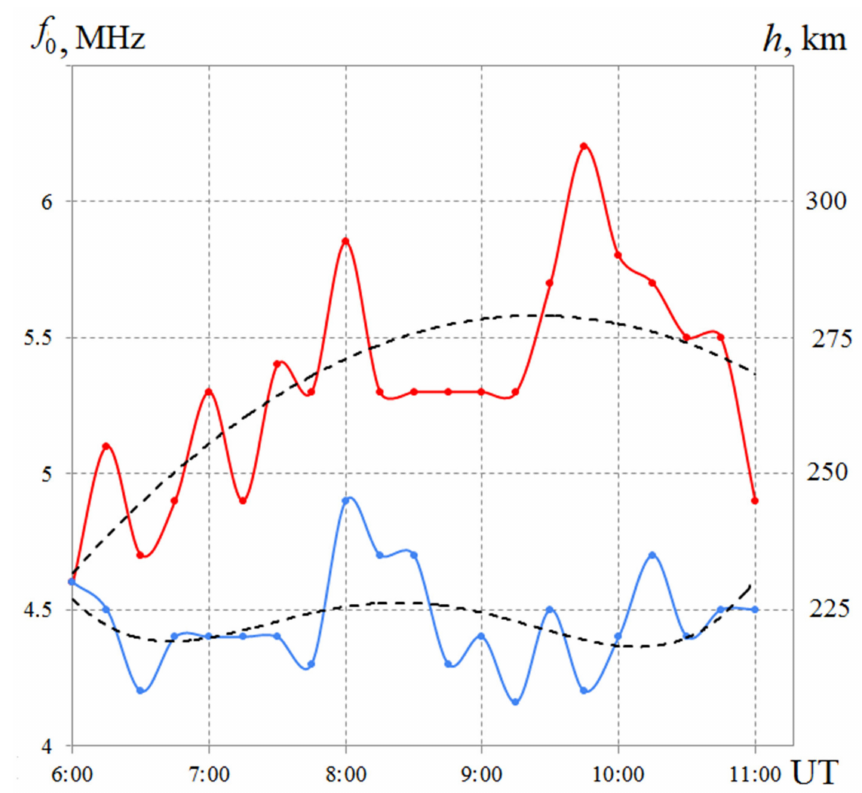
Figure 9. Dependence of the critical frequency f 0 of the ionosphere ( red ) and true reflection height h at a frequency of 4 MHz ( blue ) according to the CADI ionosonde (Vasilsursk) on 19 December 2019. Approximation lines are drawn by a dotted